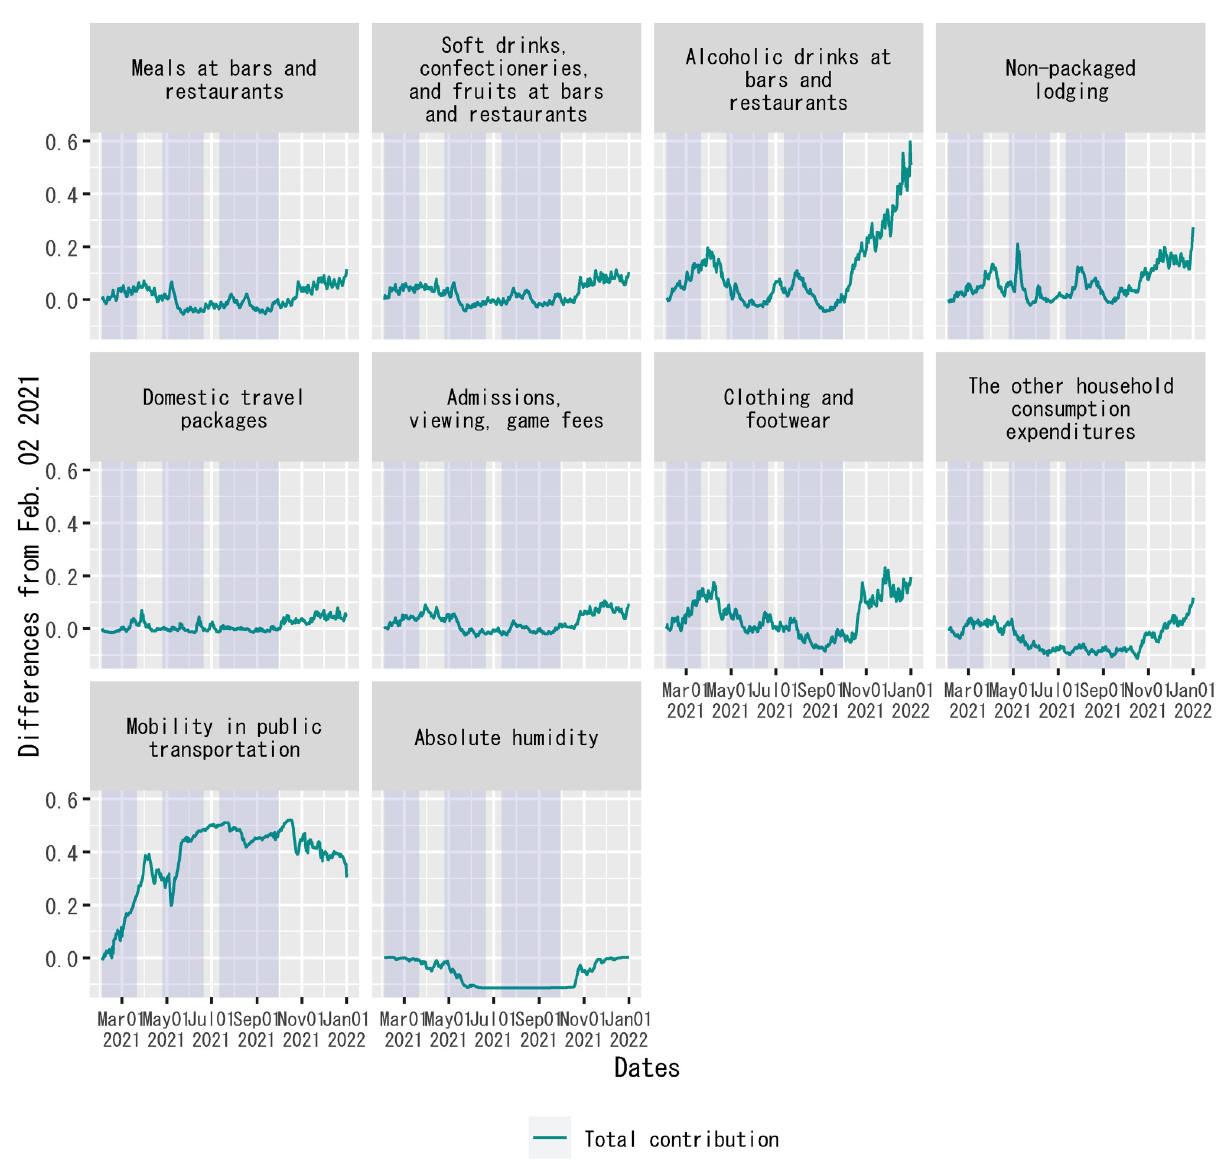
Fig 8. Decomposition of out-of-sample forecasts of the regression: Differences from a benchmark date. Each panel plots the differences in the product of an explanatory variable and the posterior mean of the corresponding regression coefficient from February 2, 2021. For out-of-sample forecasts, the time dummy for the second state of emergency is set to zero without changing the posterior means of regression coefficients. The sample period shown in the figure is from February 2, 2021, to January 1, 2022. For household expenditures and mobility in public transportation, “Total contribution” indicates differences in the posterior mean of γ j F ( X j , t ) + θ j F ( D AH , t X j , t ) in Eq (7) on each date from February 2, 2021. Each shadowed period indicates a state of